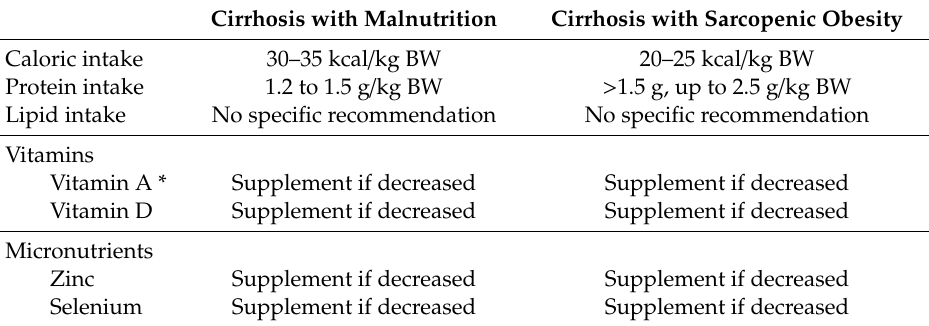
Table 1. Nutrition management in patients with advanced liver cirrhosis. Cirrhosis with Malnutrition Cirrhosis with Sarcopenic